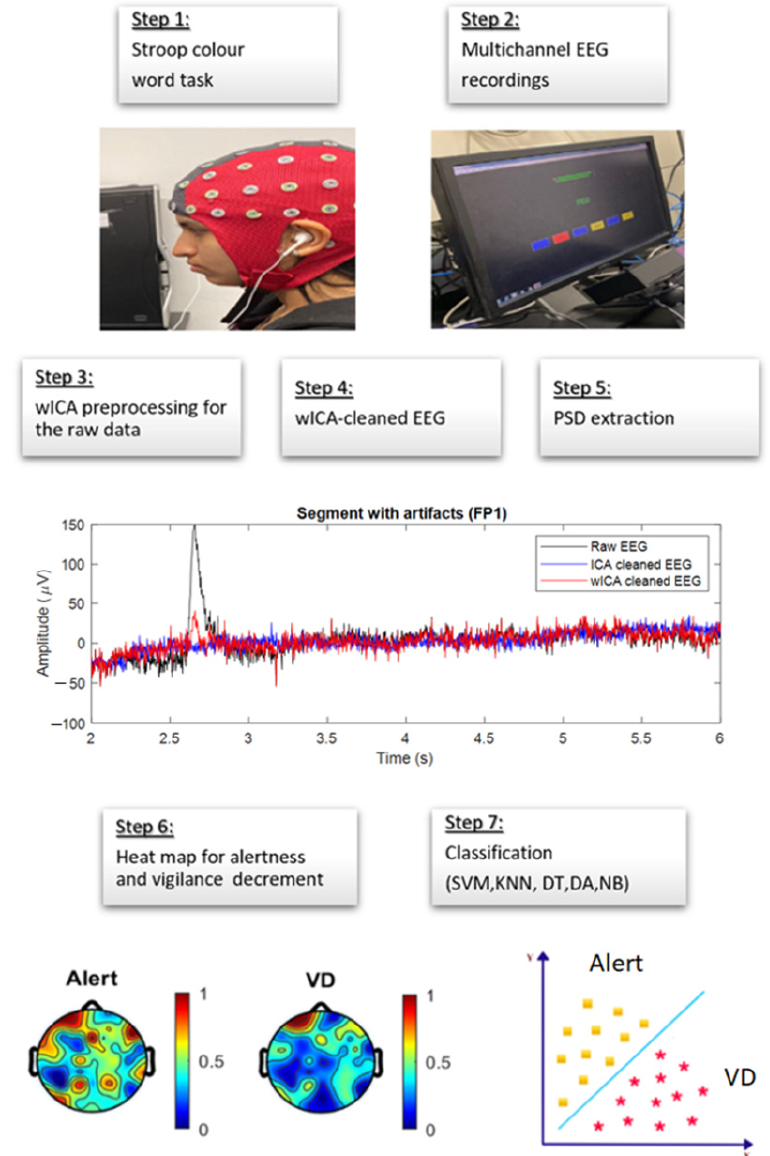
Figure 3. Flow chart for EEG data analysis using wICA in vigilance level assessment. The yellow squares and asterisks represent alertness and vigilance decrement in the feature space.